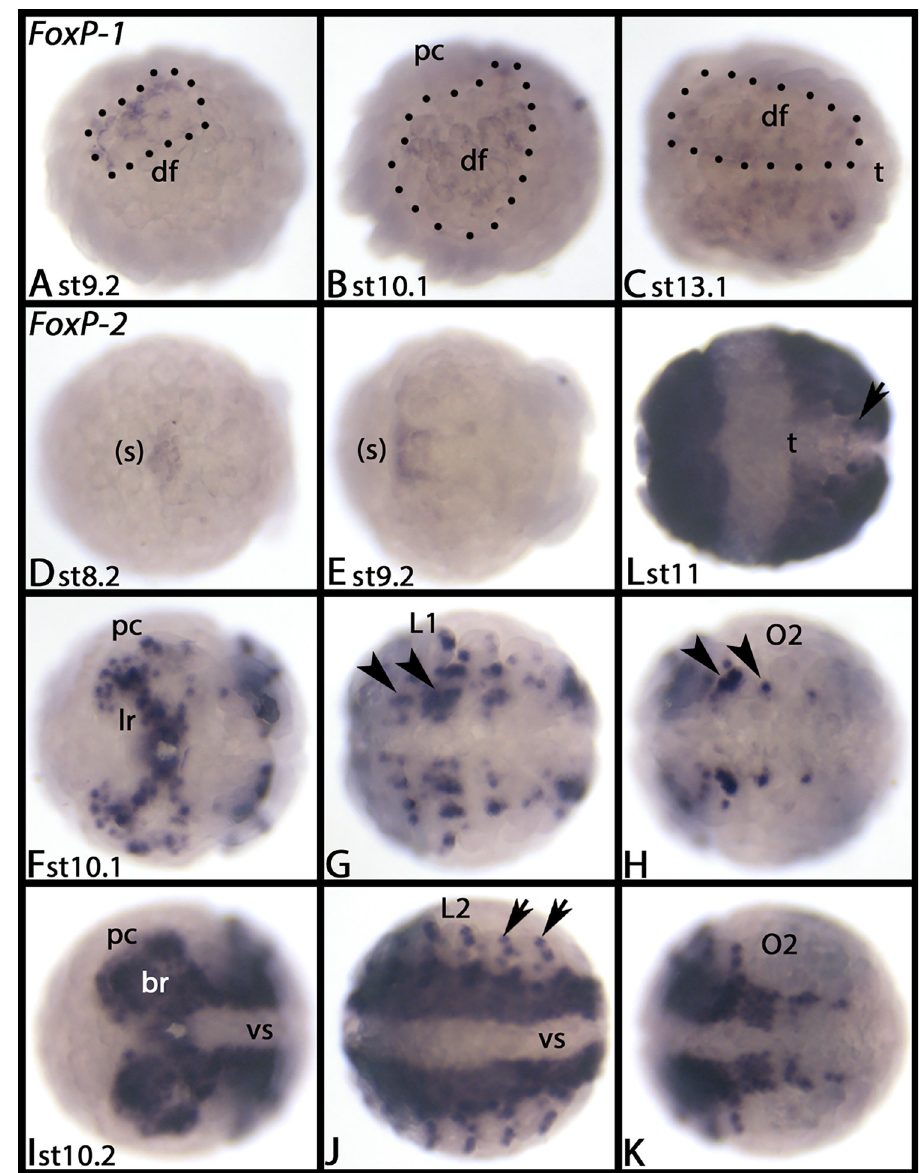
Fig 20. Expression of Parasteatoda FoxP-1 (A-C) and FoxP-2 (D-K). In all panels, anterior is to the left. Panels A and B show lateral view; panel C and L show dorsal views. All other panels show ventral views. Dotted lines mark the area of expression in the dorsal field. Arrowheads in panels G and H point to expression in the VNS. Arrows in panel J point to dot-like expression at the dorsal edge of the embryo. Abbreviations in Table 2. DAPI staining of the embryos shown in this figure are presented in S17